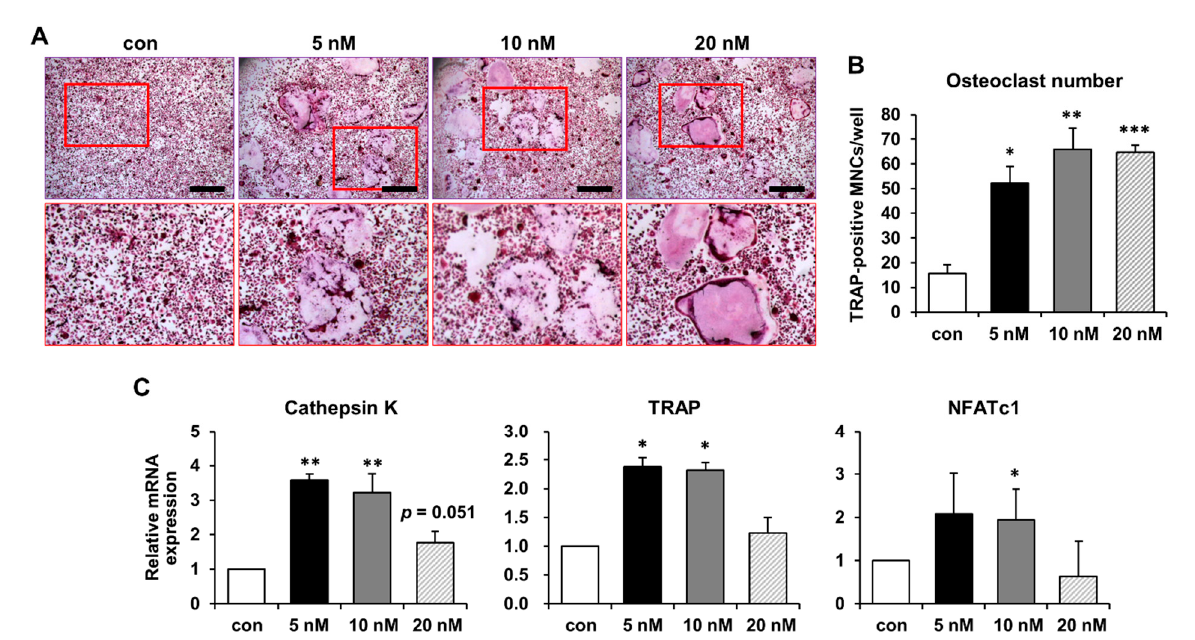
Figure 3. Effect of recombinant human S100P protein on the differentiation of bone marrow-derived macrophages (BMMs) into mature osteoclast-like cells. ( A ) BMMs were cultured in osteoclast differentiation medium containing M-CSF (20 ng/mL) and RANKL (20 ng/mL) in the presence of S100P at concentrations of 5, 10, and 20 nM. The cells were stained with TRAP to examine osteoclast differentiation. Scale bar, 500 μ m. High magnifications of the red rectangles in the upper panels are shown in the lower panels. ( B ) Number of TRAP-positive multinucleated cells (MNCs) with three or more nuclei was counted. *, p < 0.05; **, p < 0.01; ***, and p < 0.001 versus the control (con). ( C ) mRNA expression of cathepsin K, TRAP, and NFATc1 was evaluated by qPCR after treatment with 5, 10, and 20 nM S100P protein during osteoclast differentiation. The relative mRNA expression level was plotted against gene expression levels in the control (con), which were set to 1.0. The results are representative of three independent experiments. *, p < 0.05 and **, p < 0.01 versus con.